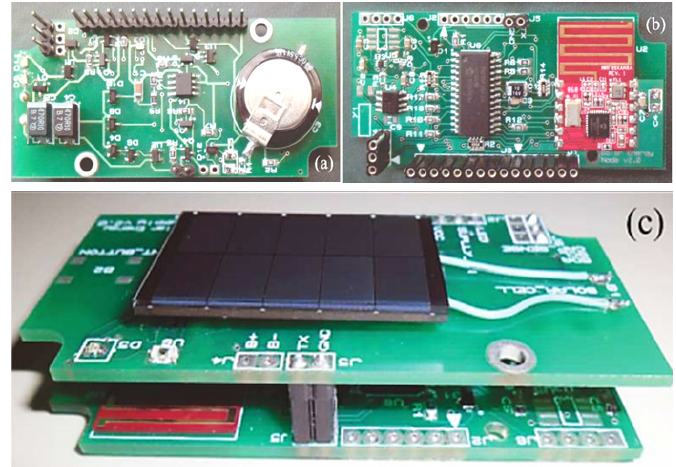
Figure 5. Photographs of the device prototype: ( a ) photovoltaic energy harvester; ( b ) WSN node; ( c ) assembled device. Overall dimensions are 74mm × 34mm × 15mm (L × W ×